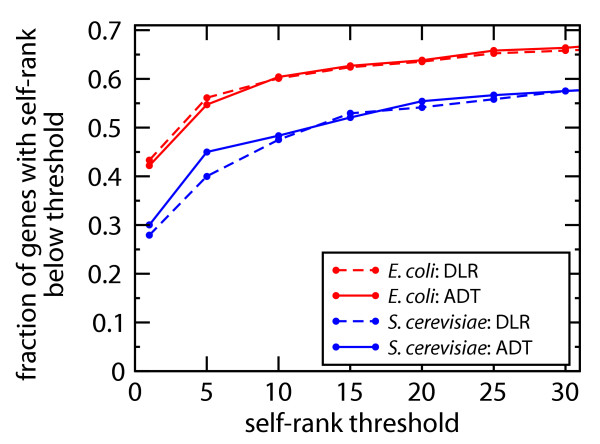
Comparison of ADT and DLR methods for combining multiple association evidence types. Fraction of enzymes predicted within different self-rank thresholds is shown for E. coli and S. cerevisiae metabolic enzymes. Predictions are based on the combined association evidence (see Methods, Table 1), using two different methods: DLR (dashed curves), and ADT (solid curves).